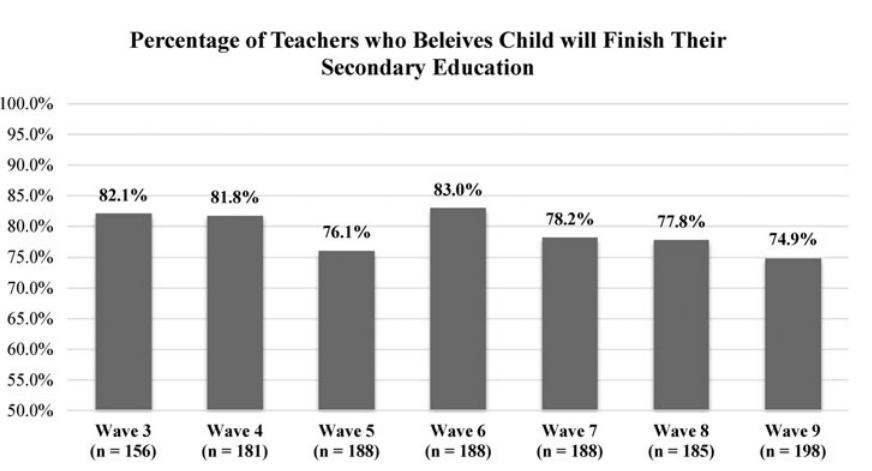
Fig. 5. Teacher expectations regarding whether Indigenous children will complete secondary